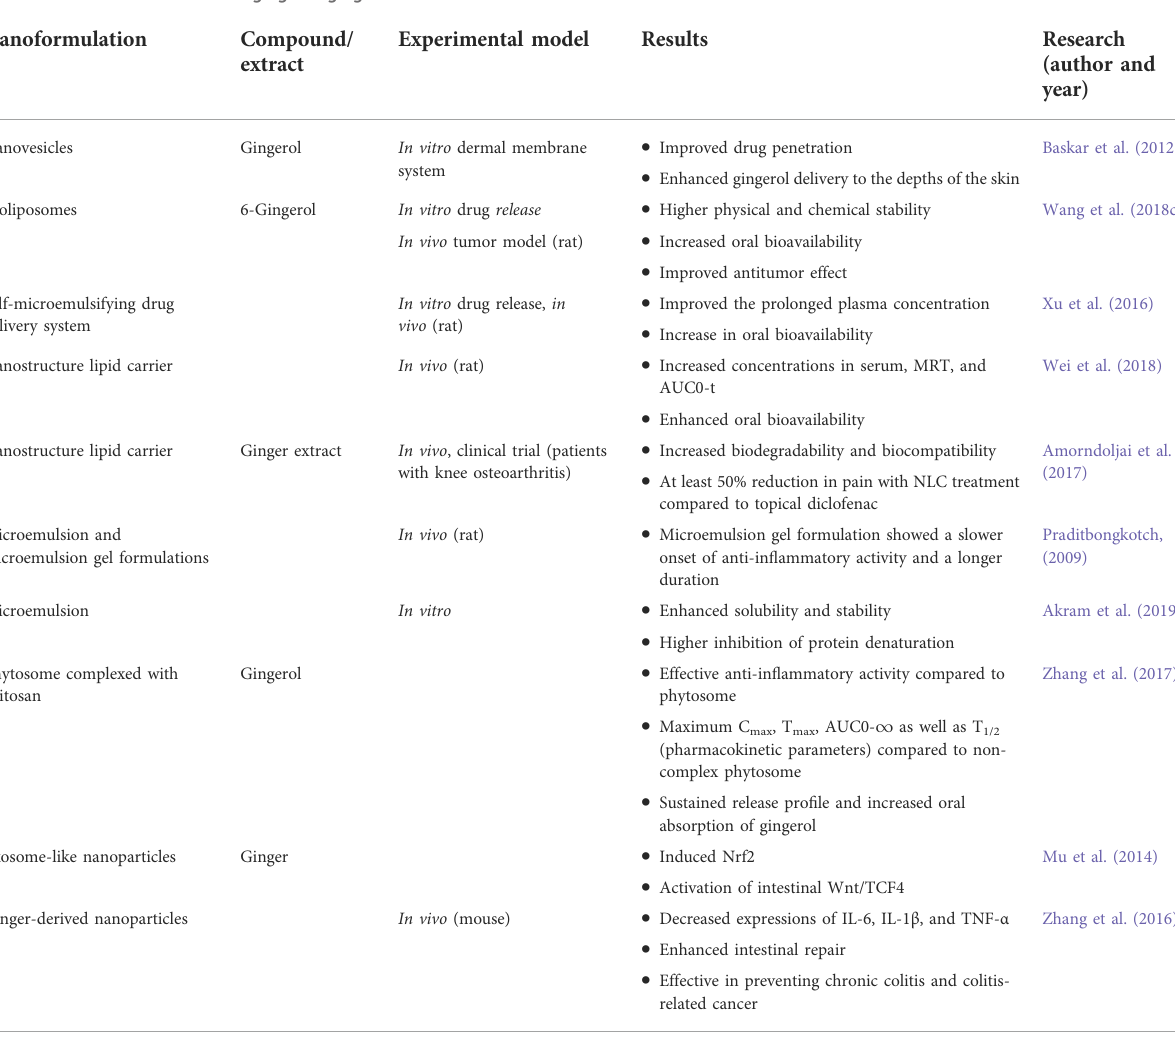
TABLE 3 Nanoformulations with gingerol/ginger